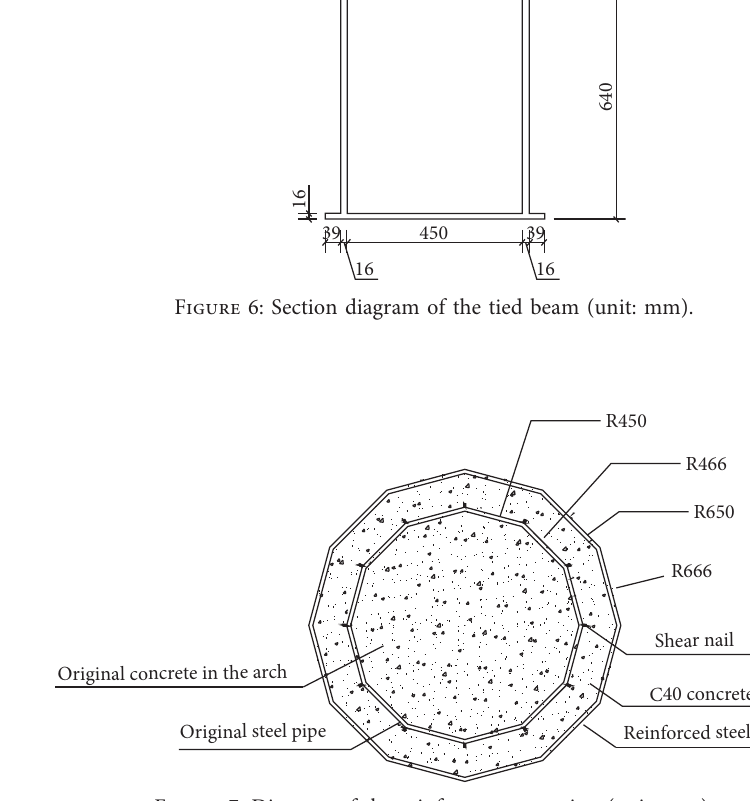
Figure 7: Diagram of the reinforcement section (unit: